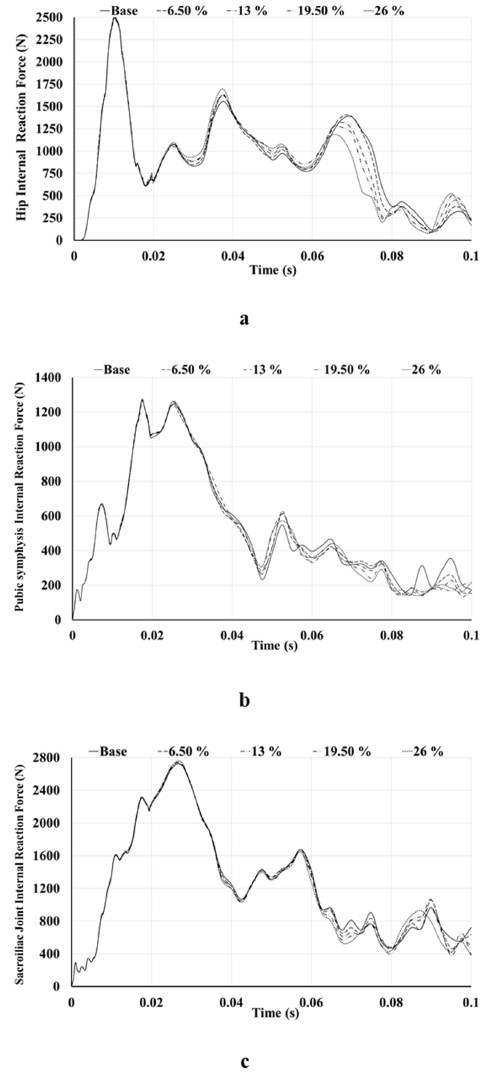
Figure 4. Internal reaction force: effect of ( a ) TST stiffness at the hip; ( b ) TST stiffness at the pubic symphysis; ( c ) TST stiffness at the sacroiliac joint.